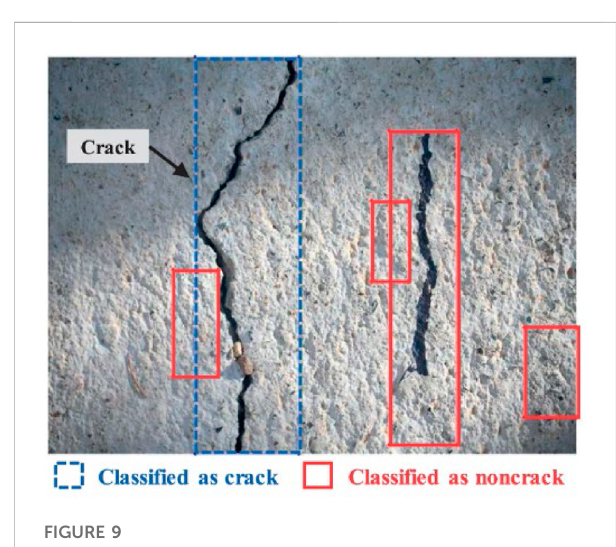
FIGURE 9 Classi fi cation of cracked and crack-free surfaces (Kim et